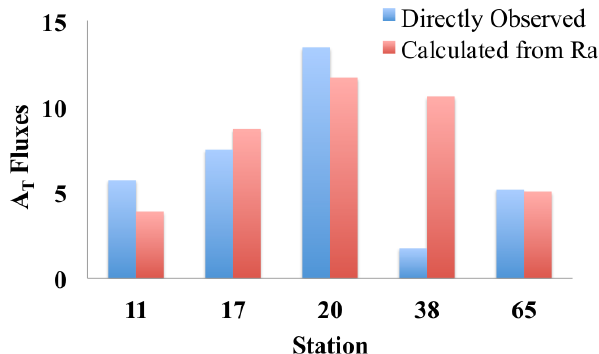
Figure 10. Directly measured A T fluxes for the SNS compared to A T flux estimations based on Ra measurements. Figure taken from Burt et al. (2014). Fluxes in mmolCm − 2 d − 1